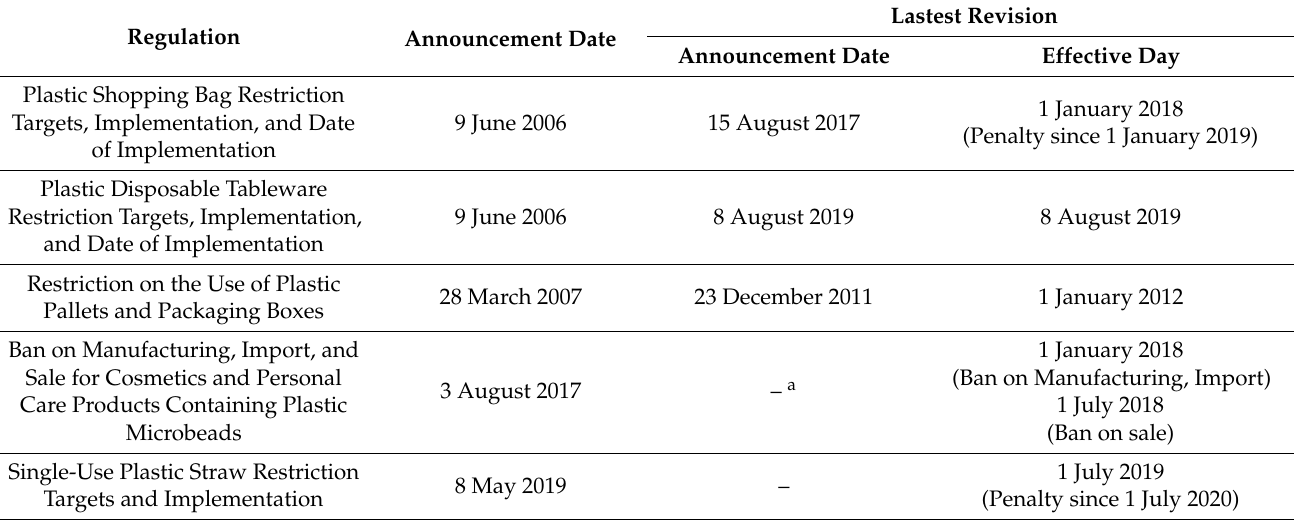
Table 2. Major regulations governing the restrictions on the use of plastic products in